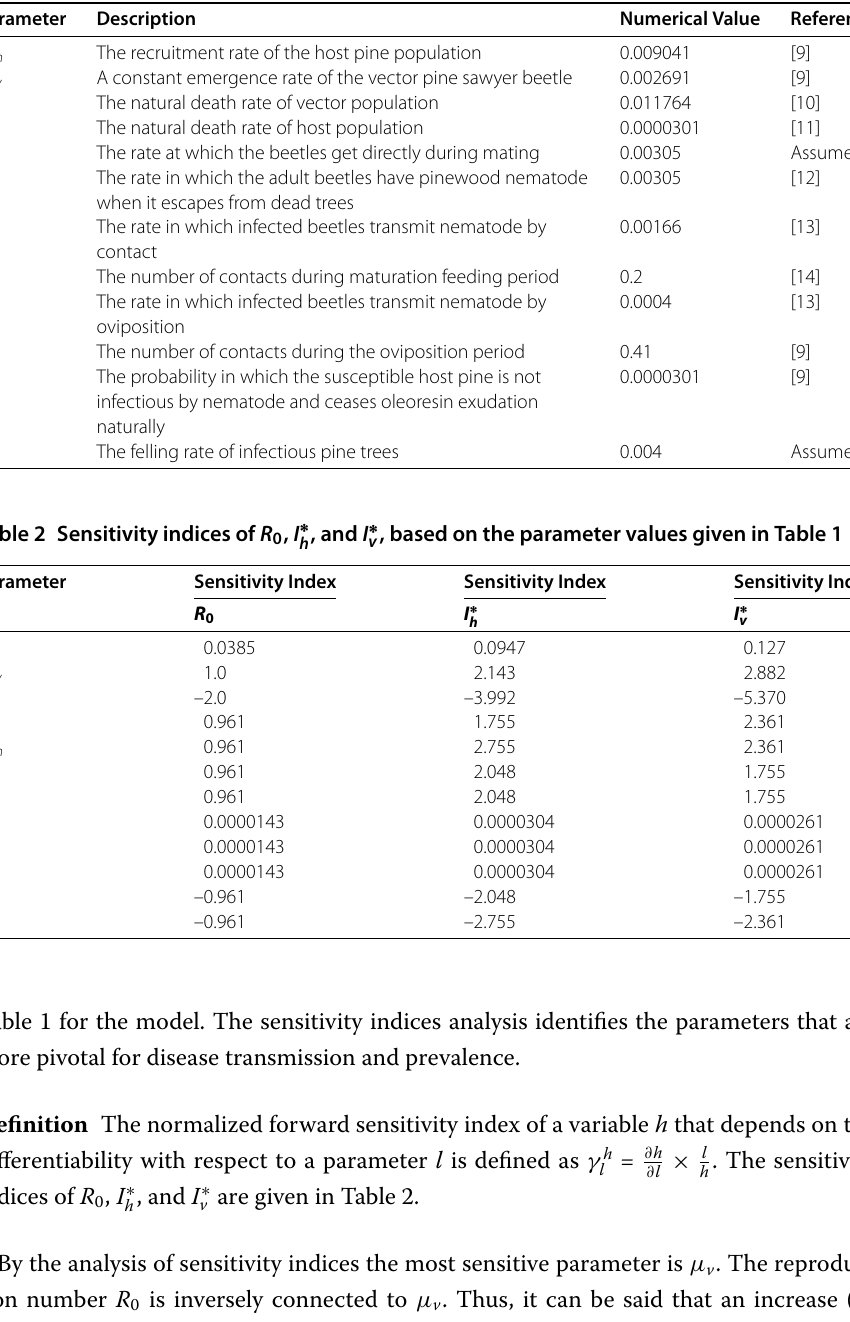
Table 1 Parameter values used for sensitivity analysis